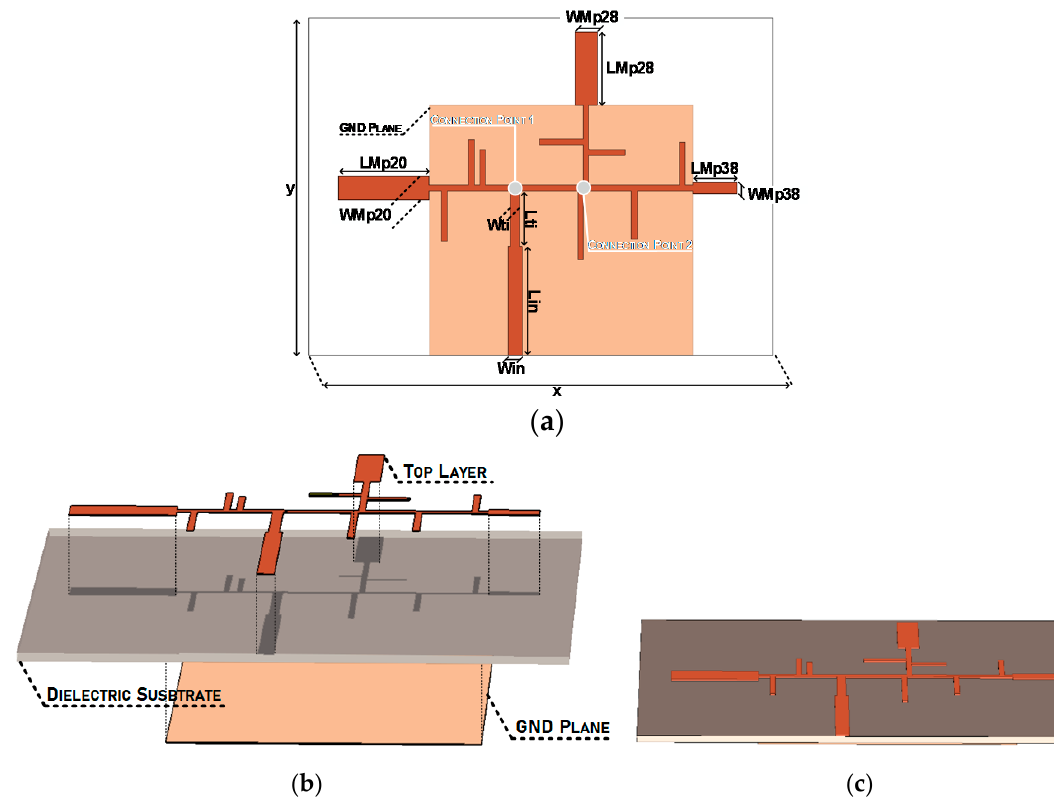
Figure 5. Tri-Band Antenna: ( a ) Design Parameters, ( b ) Layers Identification and ( c ) Final Structure. Table 2. Tri-Band Antenna’s Dimensions.